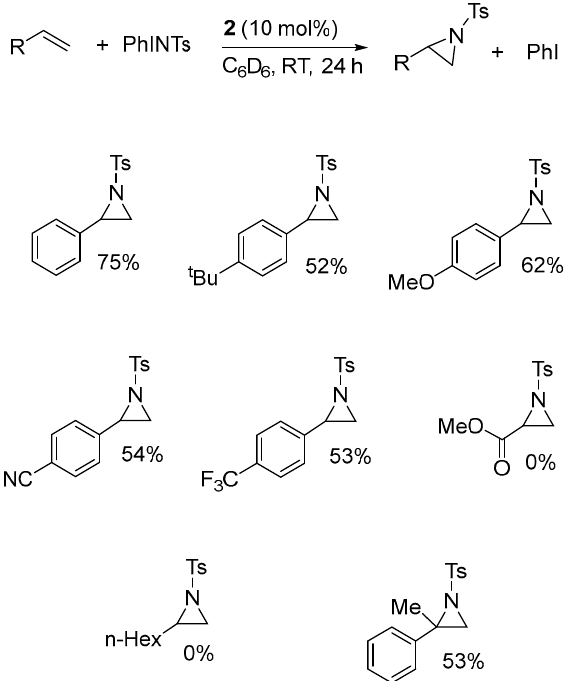
Figure 2. Aziridination of various olefins using 2 . The yields of the aziridine products were deter- mined by 1 H NMR using internal standard (1,3,5-trimethylbenzene)